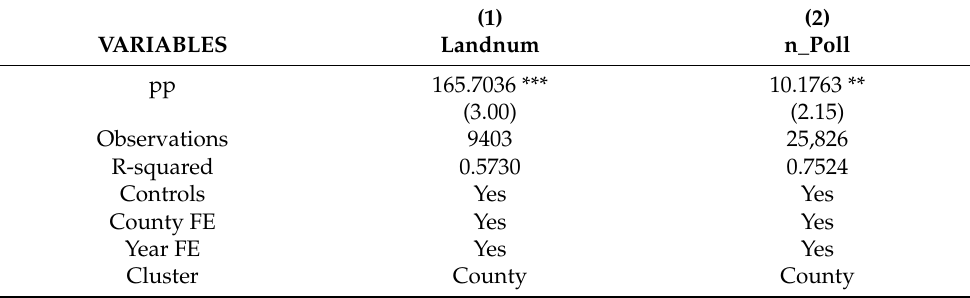
Table 6. Mechanism